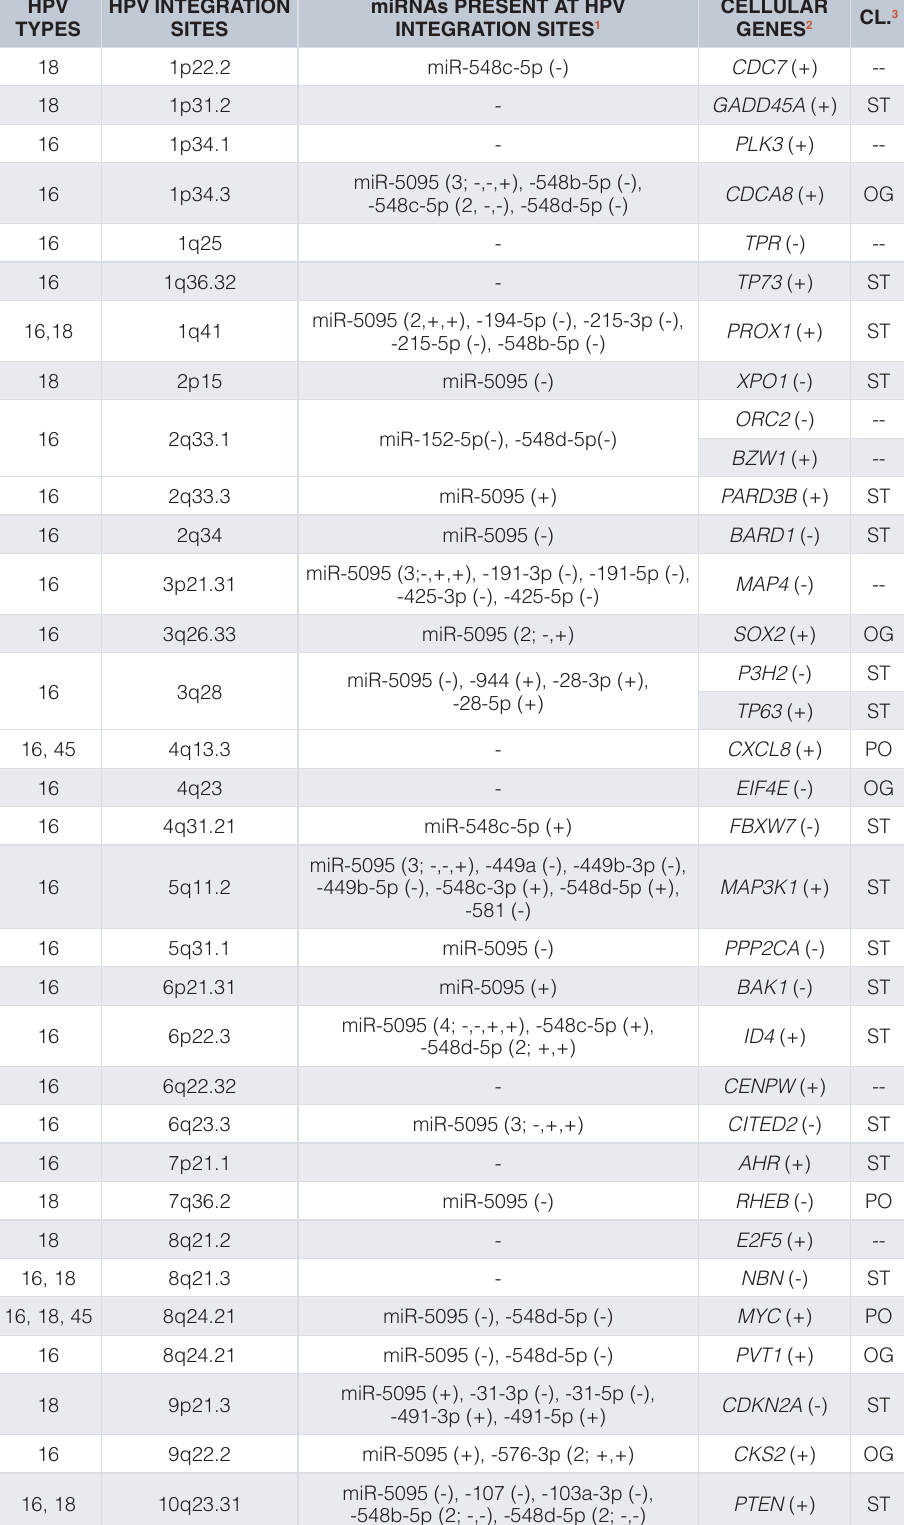
Table 5. miRNAs in HPV integration sites and their correlation with cell cycle regulatory